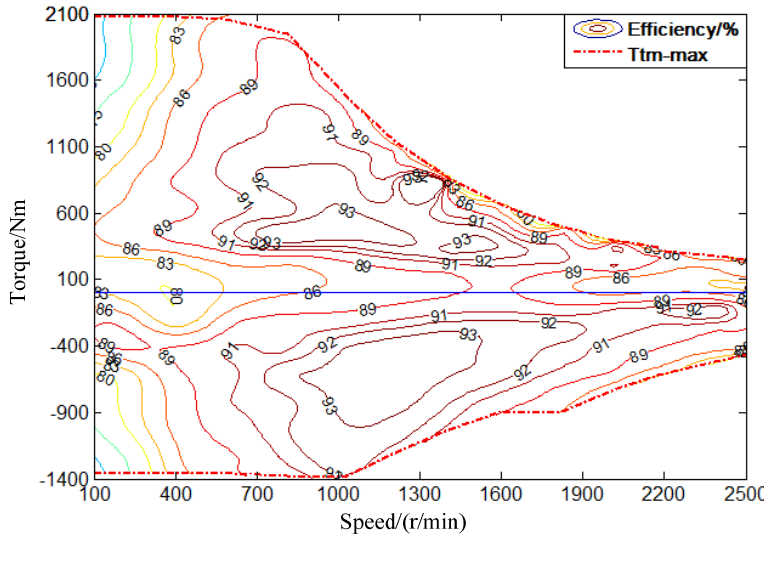
Figure 6. The traction motor efficiency